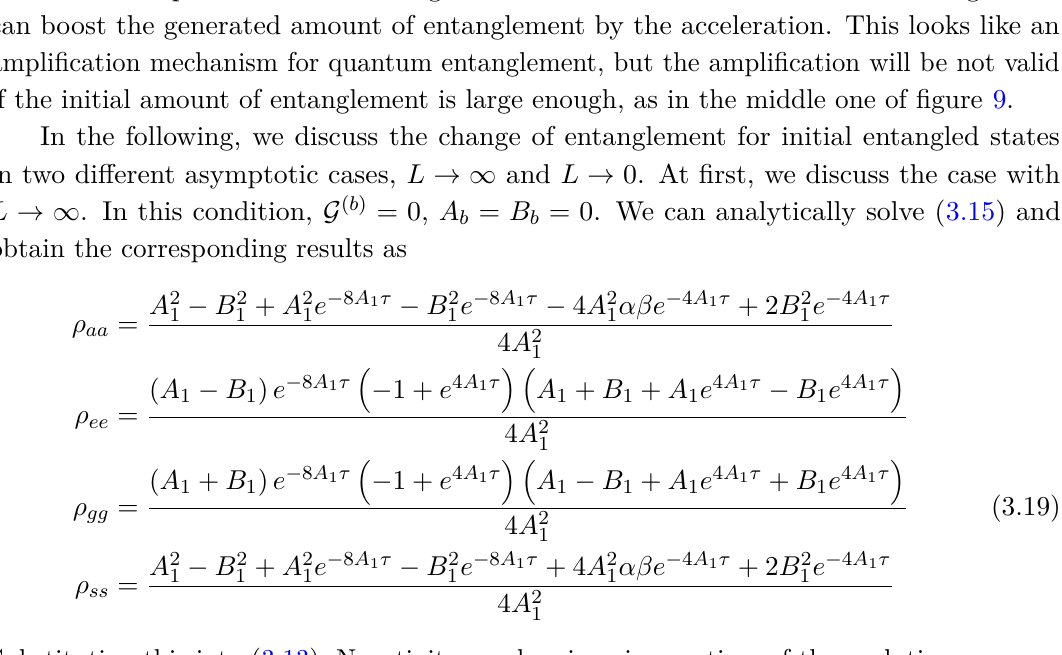
√ √ 2 , α = 1 / (2 2) , α = 0 . 01 , respectively, from left to